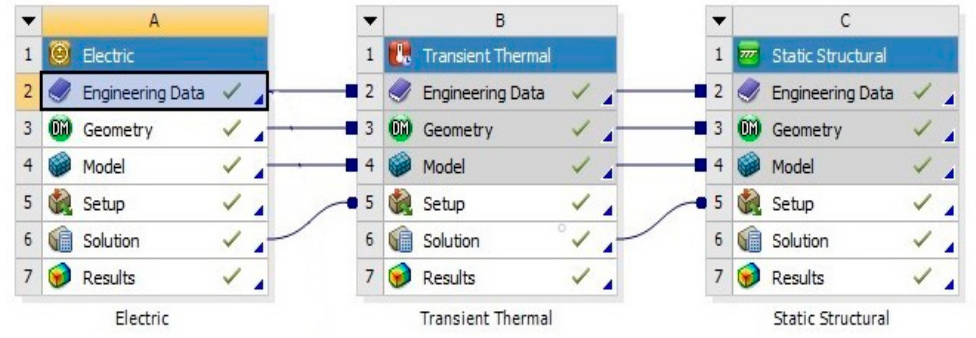
Figure 2. Simulation setup for the model.